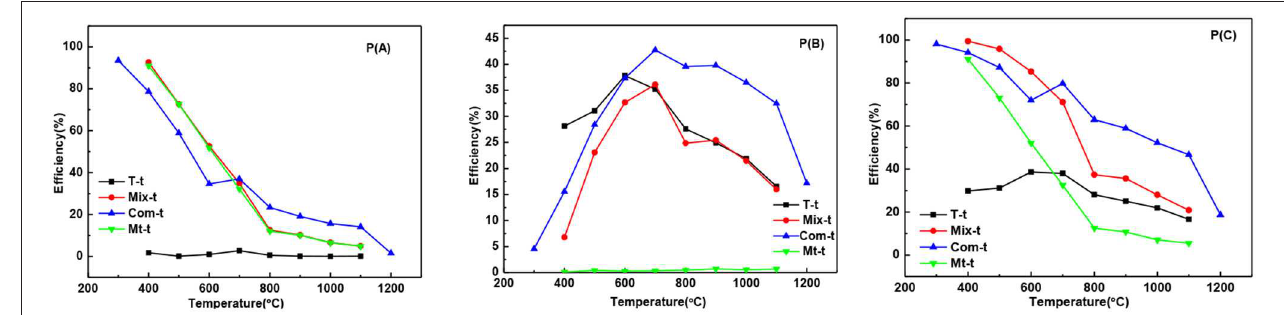
FIGURE 6 | The curves of the adsorption degradation percentage P(A) , the photocatalytic degradation percentage P(B) , and the total degradation percentage P(C) of T-t, Mix-t, Com-t,